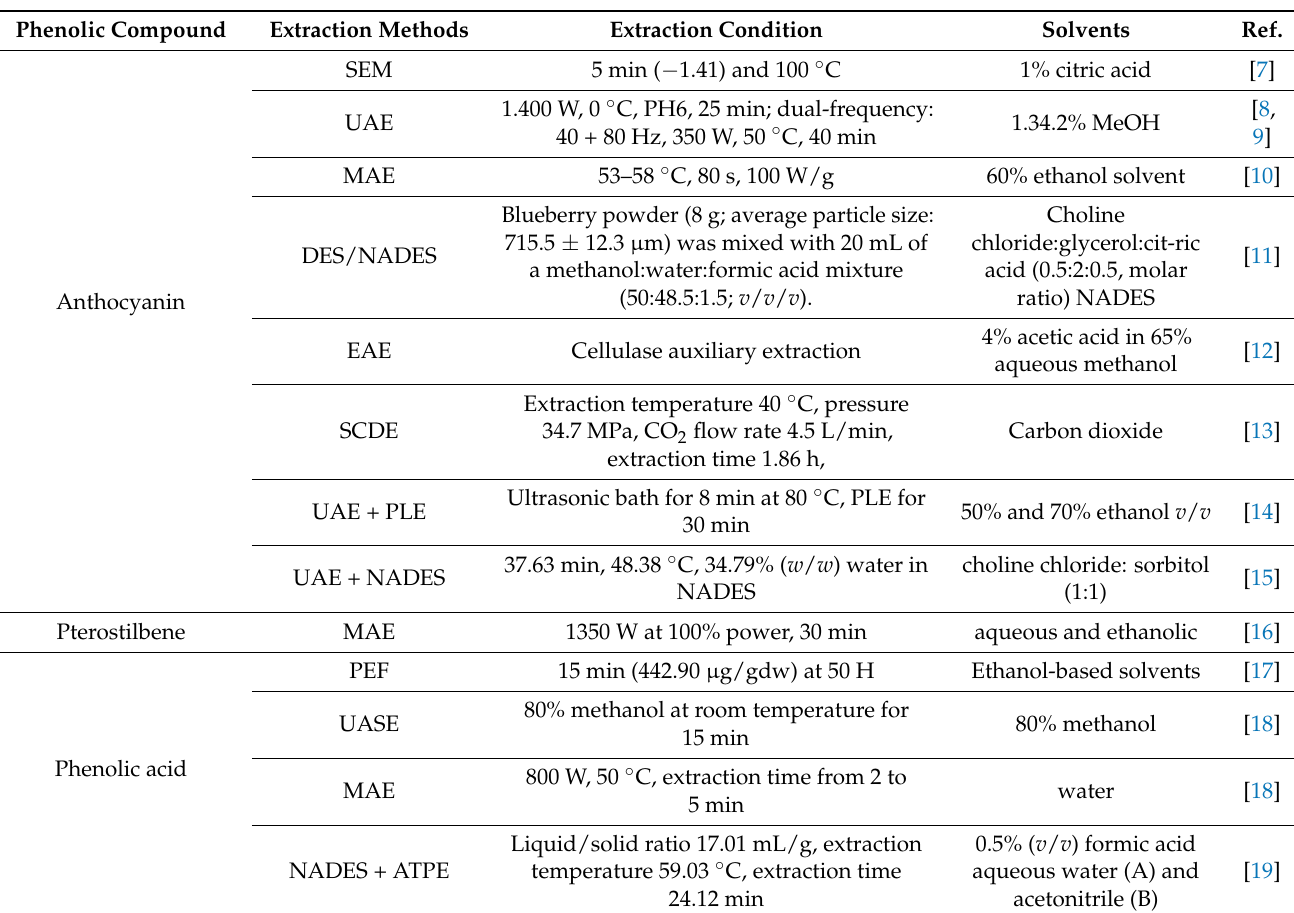
Table 1. Summary of extraction methods of phenolic compounds from blueberries discussed in this paper. Phenolic